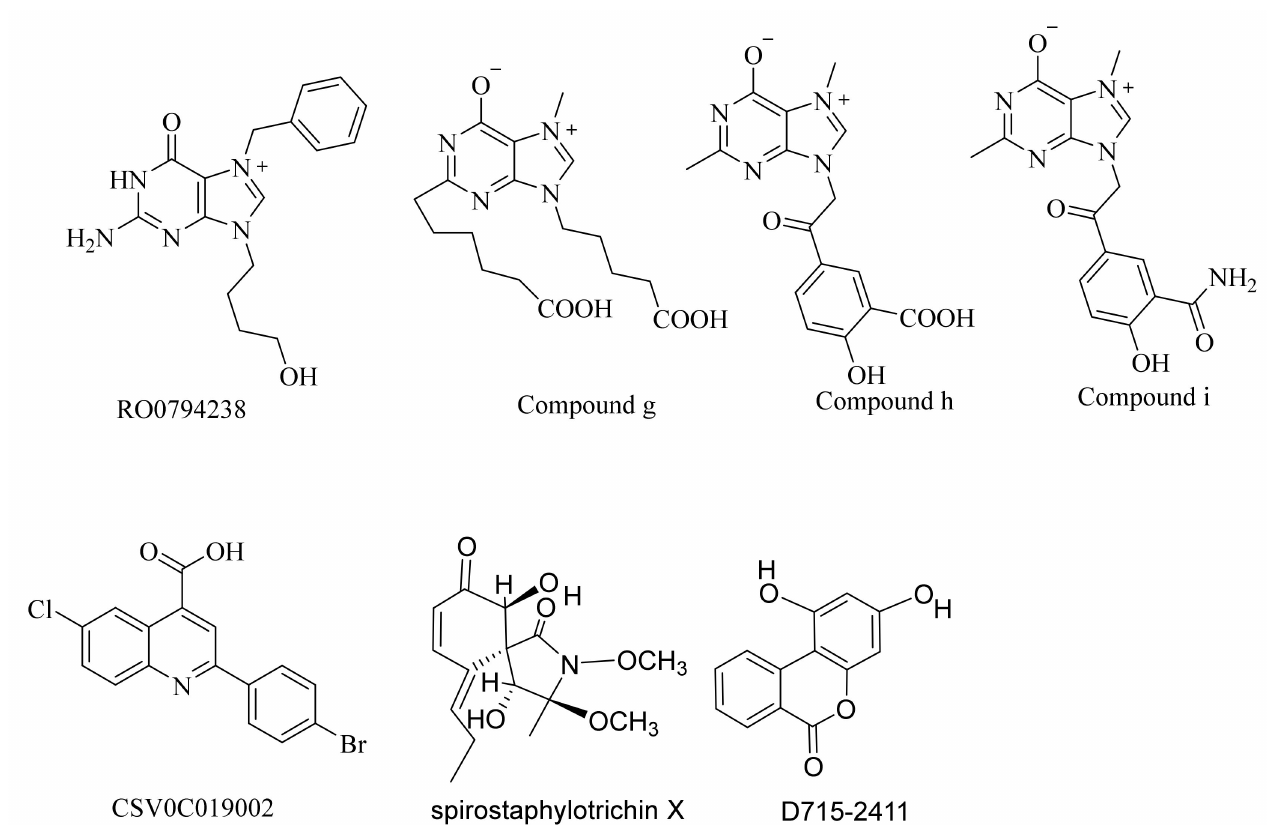
Figure 2. The structure of PB2 inhibitors of other structure